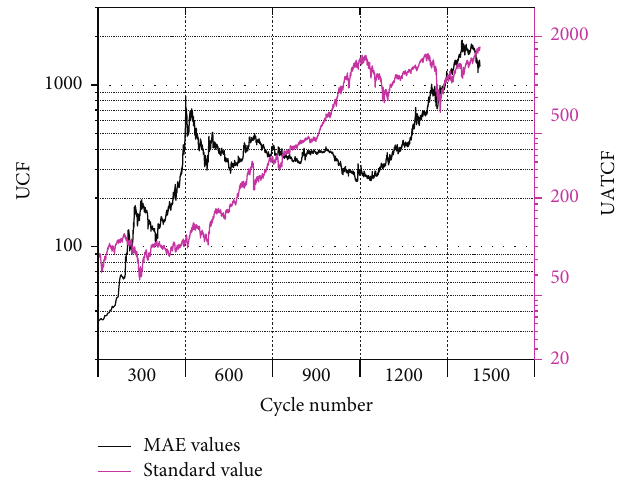
Figure 7: MAE values of the algorithm on different training sets.